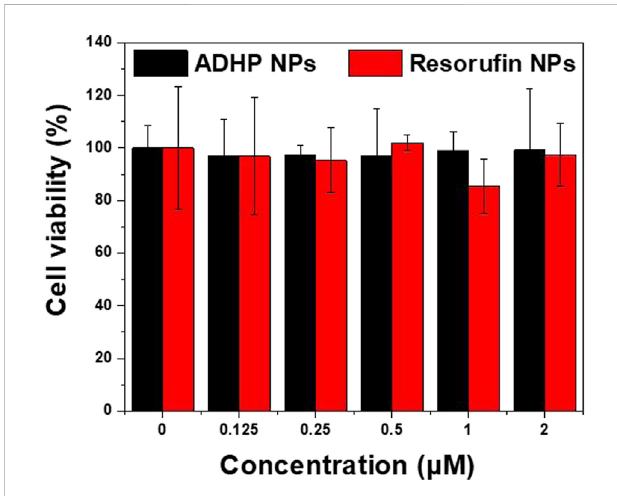
FIGURE 4 The viability of 4T1 cells after incubation with various concentrations of ADHP NPs and resoru fi n NPs protected from light for 24